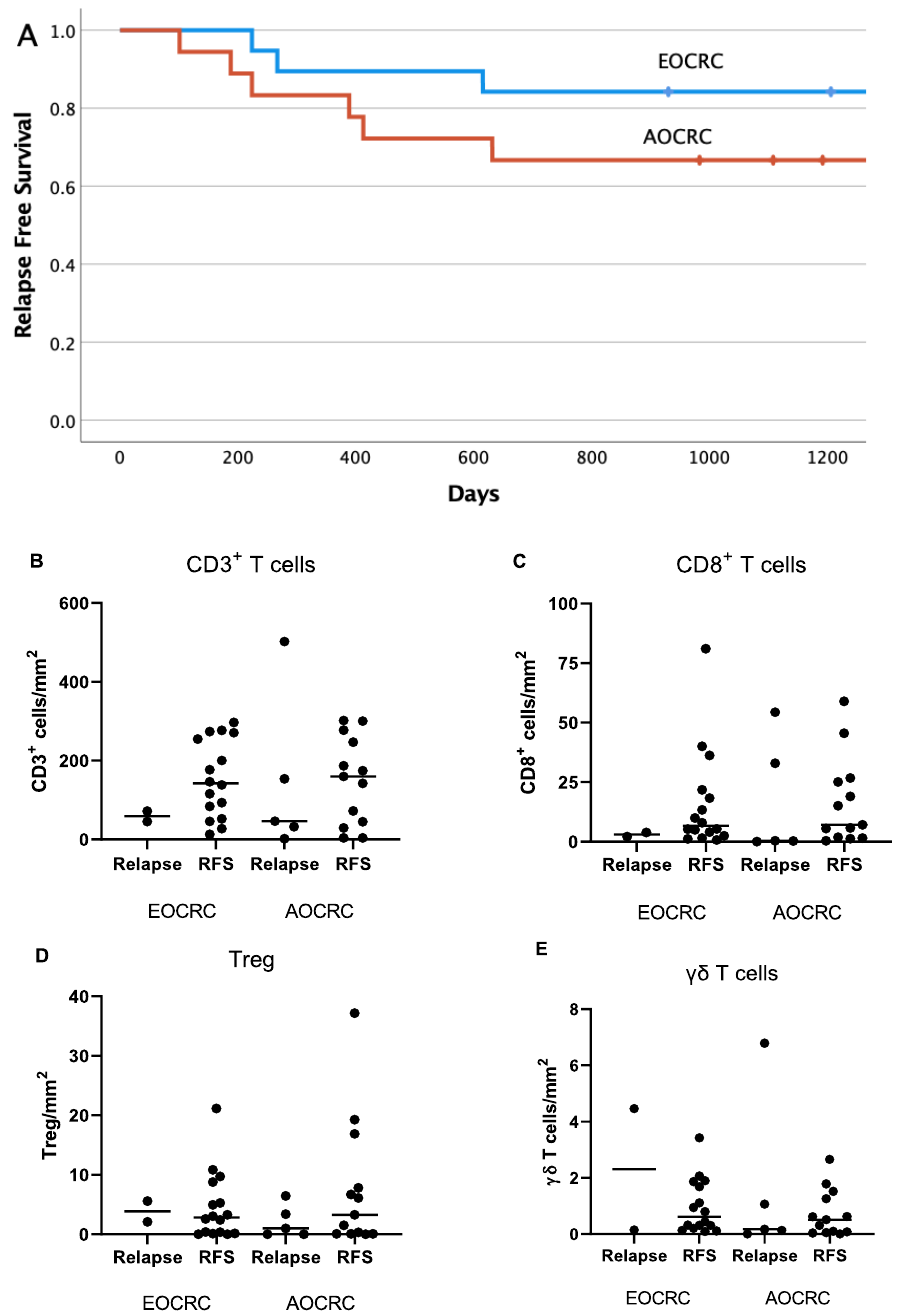
Figure 7. Intratumoral T-cell infiltration in relation to patient outcome. Kaplan–Meier plot ( A ) show- ing relapse-free survival in EOCRC (blue) and AOCRC (red) patients with stage I–III tumors during a 3-year follow-up period ( p = 0.41 between groups). The density of all T cells ( B ), CD8 + T cells ( C ), Treg ( D ), and gd T cells ( E ) in tumors from EOCRC and AOCRC patients who experienced a relapse within 3 years or had a relapse-free survival (RFS) was determined by immunofluorescence. Symbols show individual values, and lines indicate the median.